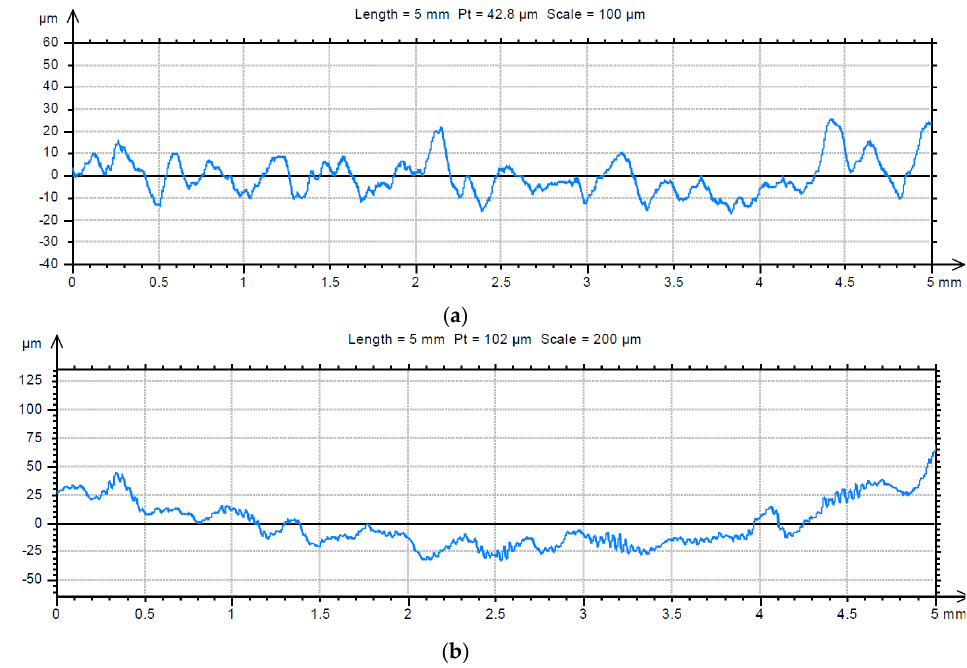
Figure 7. Representative profile lines for the reference material (PE) ( a ) and biofilm coated material ( b